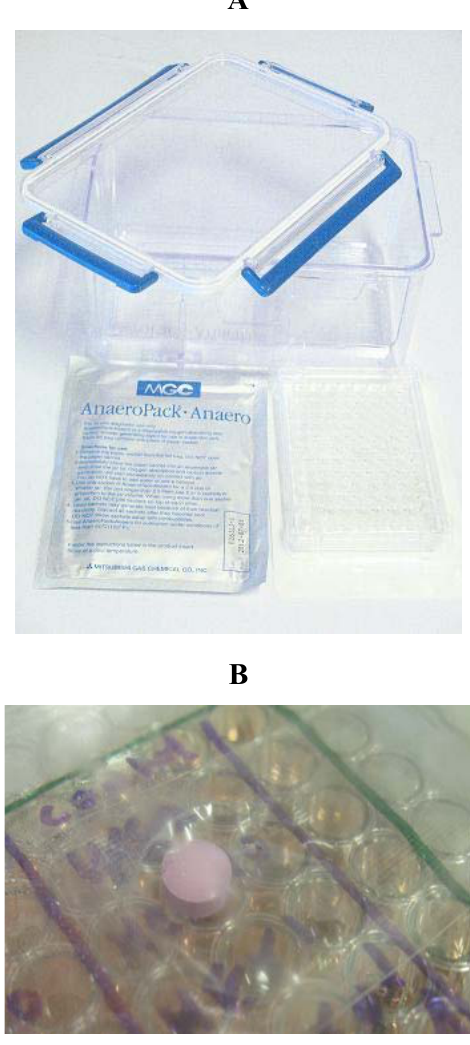
Figure 9. ( A ) Oxygen indicator tab in hypoxic conditions; ( B ) Oxygen indicator tab